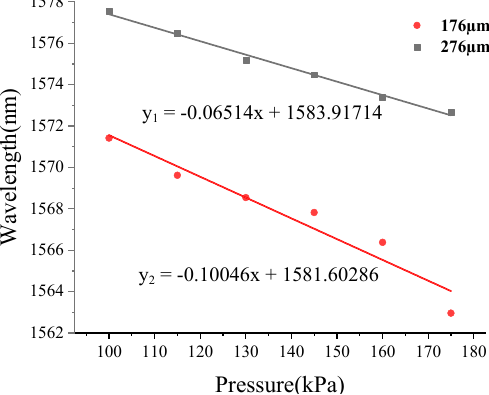
Figure 10. Pressure characteristics comparison of sensors S1 and S2.